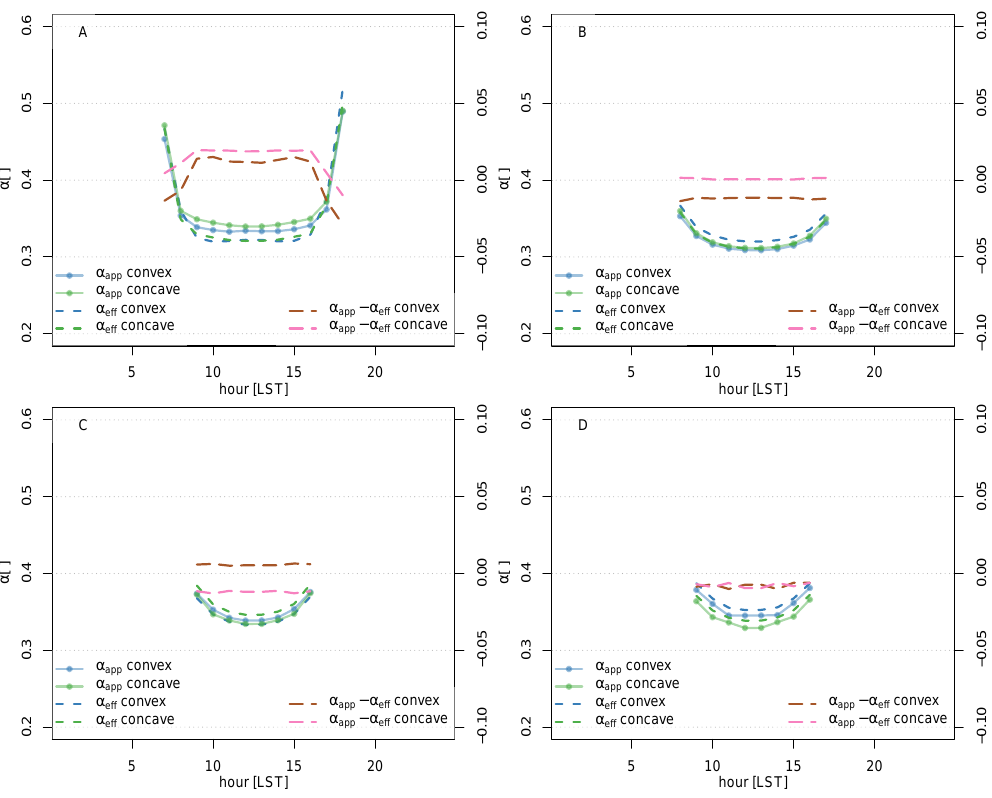
Figure 10. Diurnal modeled evolution of the apparent albedo at h = 2m, effective albedo and sampling bias (i.e., α app − α eff ) of two sample Fig. 10. Diurnal modeled evolution of the apparent albedo at h = 2 m, effective albedo and sampling bias 2-D penitente surfaces with convex and concave shapes for the experiments A–D for solar zenith angles <75 ◦ and for a constant α mat . (i.e., α app − α eff ) of two sample 2D penitente surfaces with convex and concave shape for the experiments A-D for solar zenith angles < 75 ◦ and for a constant α mat 0.12) are similar to values obtained by Dumont et al. 37